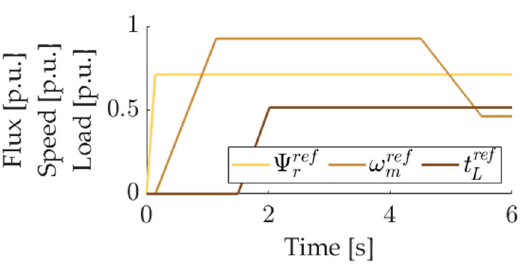
Figure 11. Reference trajectories of the rotor flux amplitude, motor speed, and load torque.